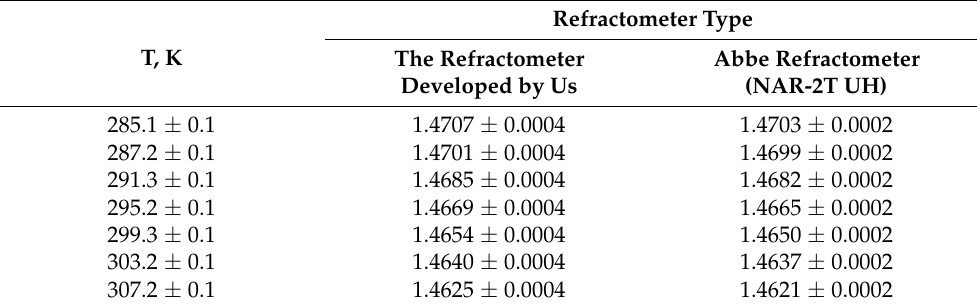
Table 1. The change in the refractive index n m of a water-alcohol 50% ethanol solution from temper- ature T.